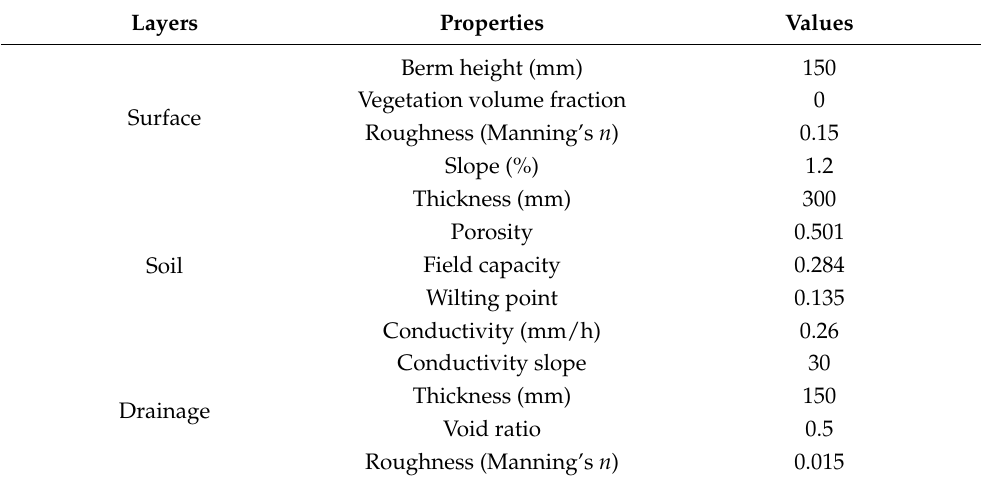
Table 3. Parameters of green roofs in the THTH